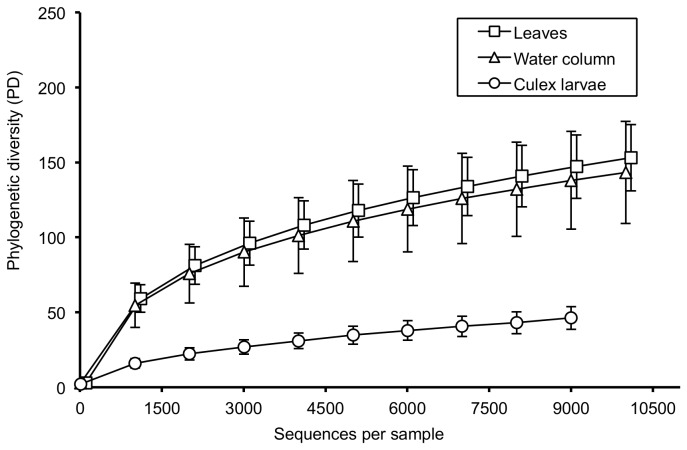
Alpha diversity measures.Alpha diversity measures based on PD_Whole tree of the bacterial communities from mosquito larvae, water column and leaves. Sequences from mosquito samples are significantly less diverse than sequences from water and plant samples. The x-axis for the phylogenetic diversity of Bacteria communities from leaf samples is offset by 100 sequences for better illustration.